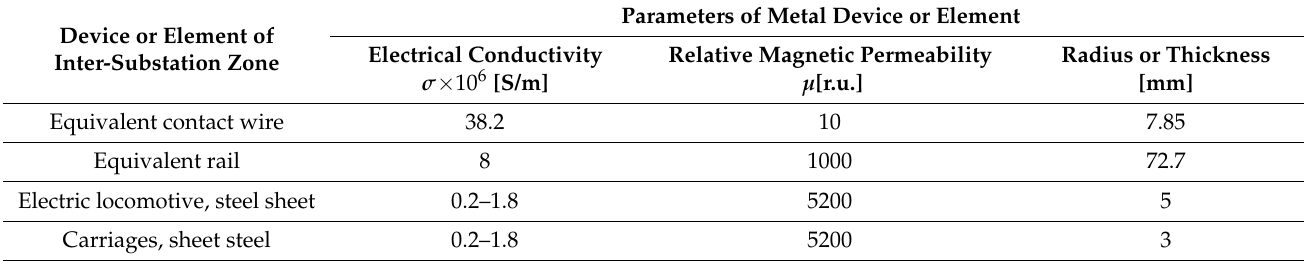
Table 1. Parameters of devices and elements of the inter-substation